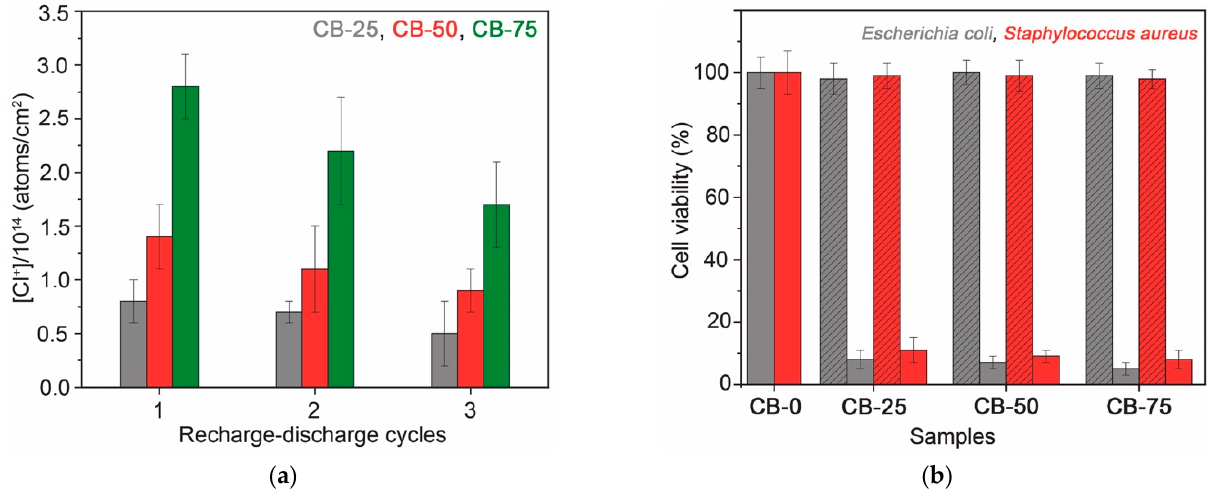
Figure 5. ( a ) The oxidative chlorine content of CB-25 , CB-50 , and CB-75 after different “recharge − discharge” cycles. ( b ) Cell viability (%) of Escherichia coli and Staphylococcus aureus colonies treated by N-H (patterned) and N-Cl films of CB-0 , CB-25 , CB-50 , and CB-75 .